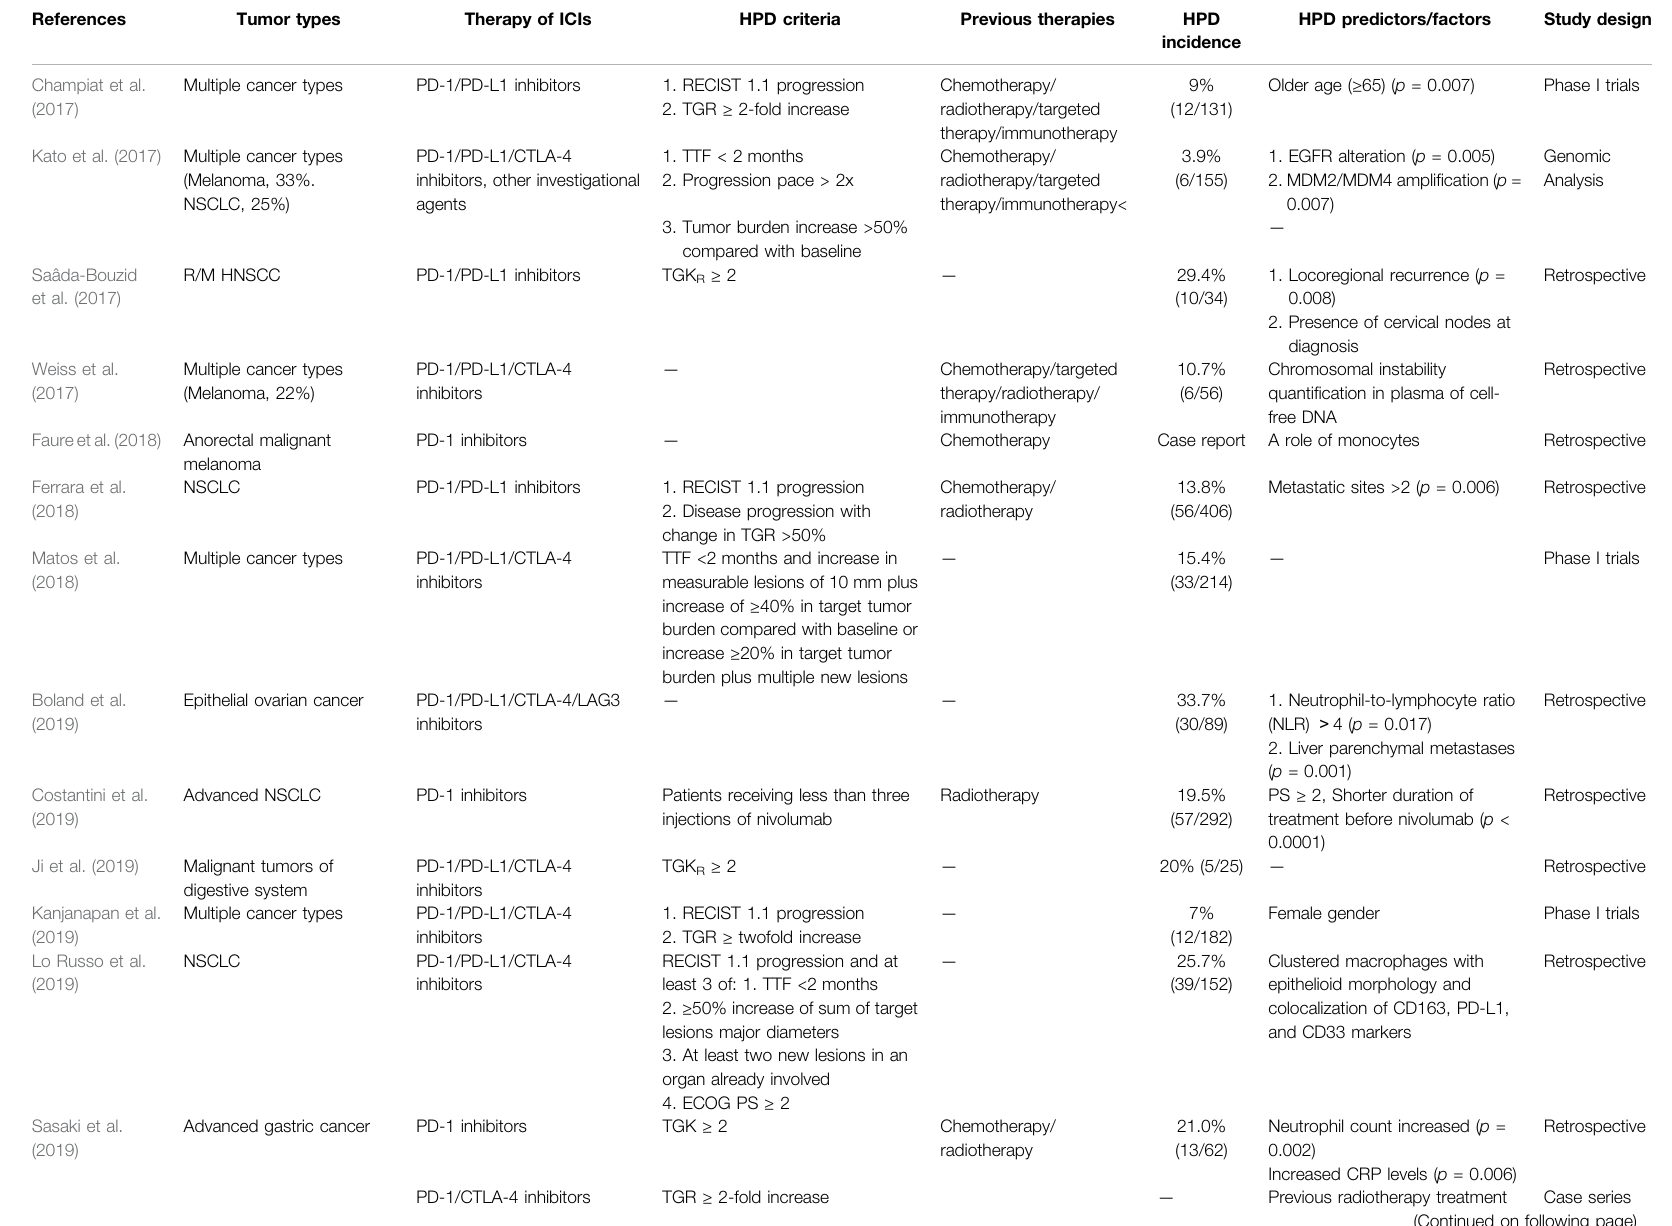
TABLE 1 | Studies on HPD after ICI